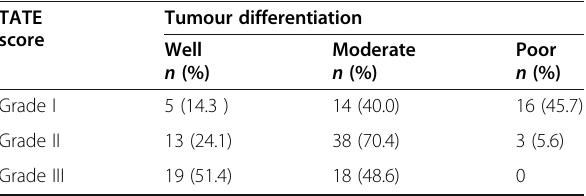
Table 6 Showing chi 2 test to find association between TATE and tumour